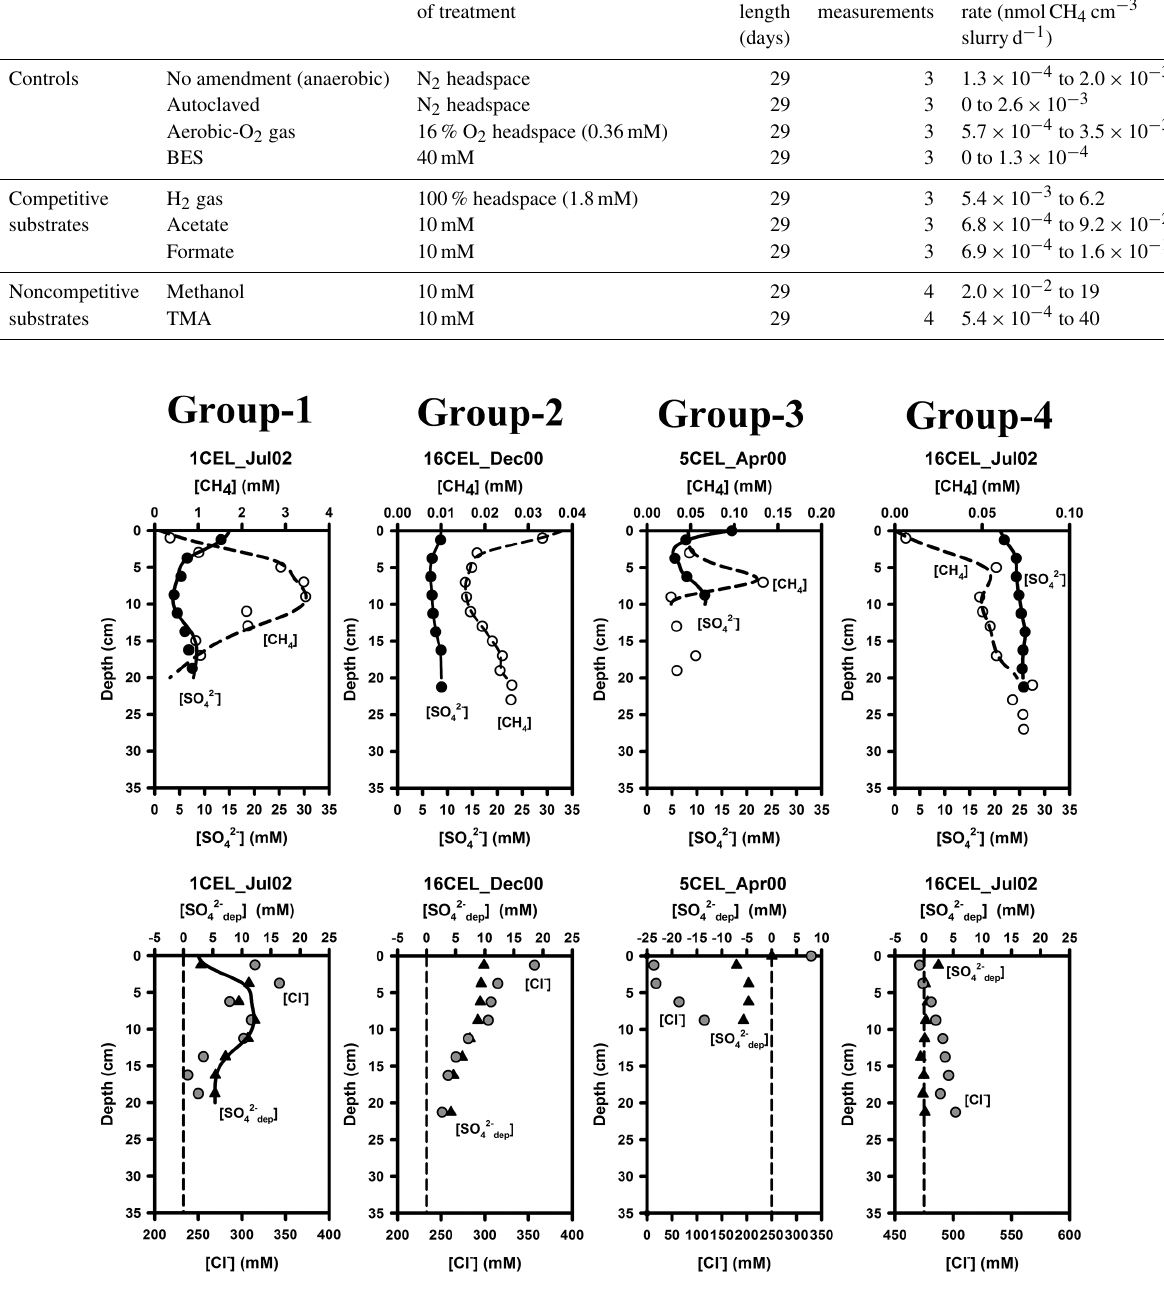
Figure 2. Depth profiles of modeled (lines), measured (circles) and calculated (triangles) concentration of dissolved methane (dashed lines; open circles), sulfate (solid lines; solid circles) in the upper panel and sulfate depletion (solid lines; solid triangles), zero sulfate depletion (dashed lines) and chloride concentration (gray circles) in the lower panel for each profile type (Groups 1–4, see text). One selected profile per group is shown here for illustration and the other profiles for each group (9 cores for Group-1, 6 cores for Group-2, 2 cores for Group-3 and 3 cores for Group-4) are presented in the Appendix A (Fig. A1). CEL and CH represent cores collected from Celestún Lagoon and Chelem